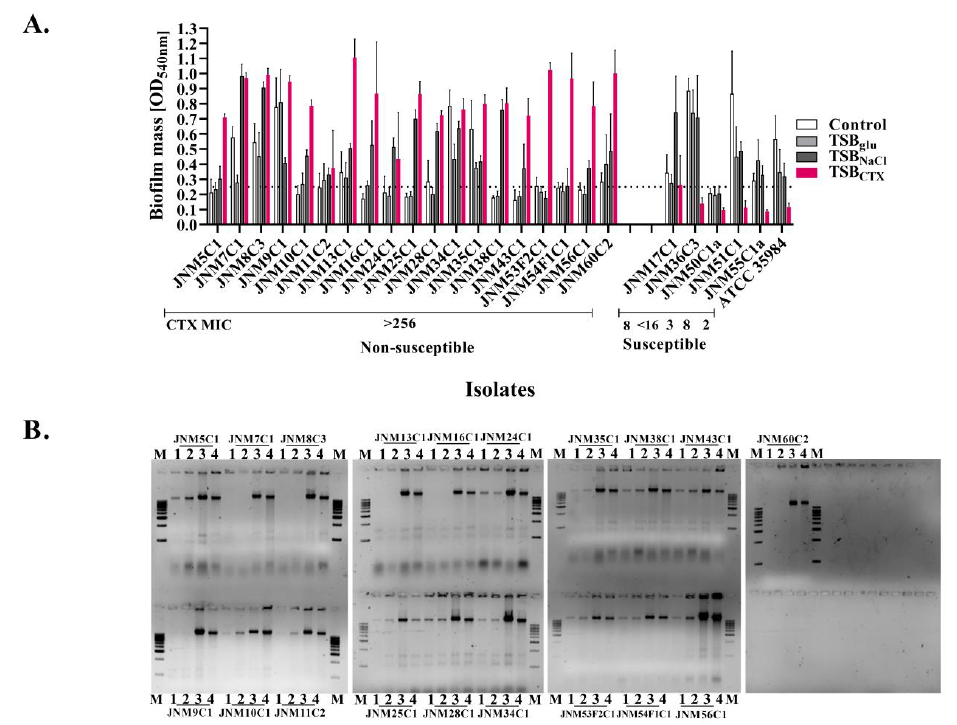
Figure 2. Cefotaxime (CTX), a commonly used ß-lactam antibiotic enhances biofilm formation among non-susceptible S. haemolyticus isolates in vitro . ( A ). Semi-quantitative determination of 24 h biofilm formation under known inducible conditions (tryptic soy broth with 1% glucose (TSB glu ) and 3% sodium chloride (TSB NaCl )) and 30µg/mL CTX(TSB CTX ) using crystal violet assays. The dotted line denotes the cut-off optical density value for biofilm formation (0.25). The biofilm-forming ATCC 35984 S. epidermidis strain served as a control. ( B ). Biofilm supernatants run on 0.8% agarose gels